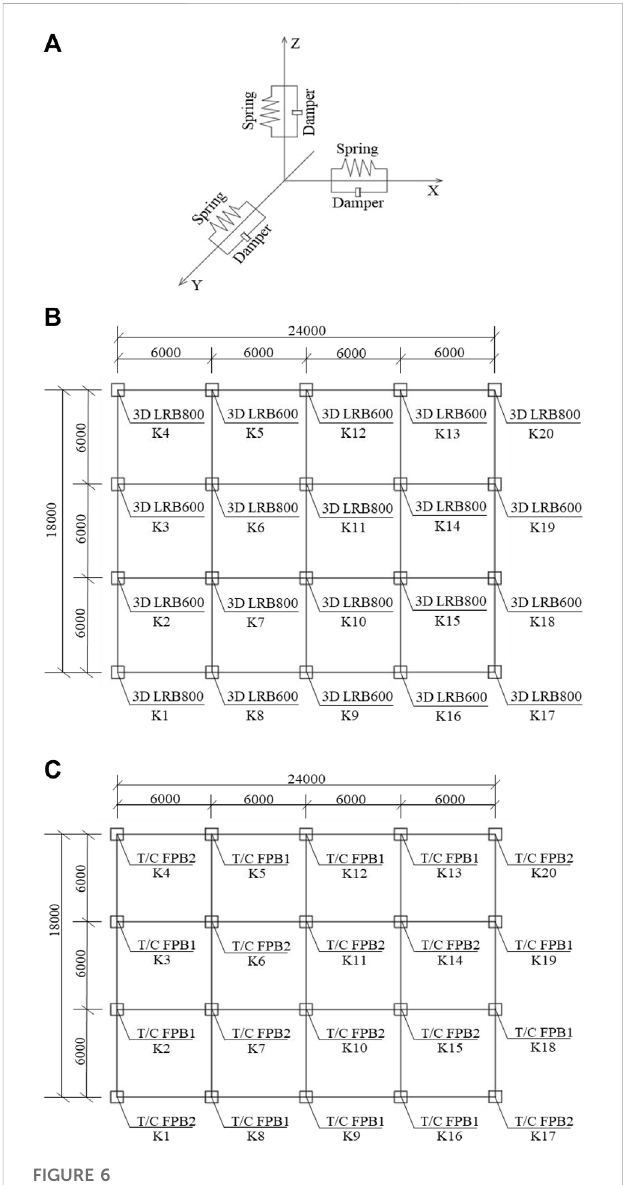
FIGURE 6 Layout of 3D isolated bearings. (A) Simpli fi ed mechanical model of the 3D isolated bearing. (B) Layout of the 3D LRB isolated bearings. (C) Layout of the 3D T/C FPB isolated